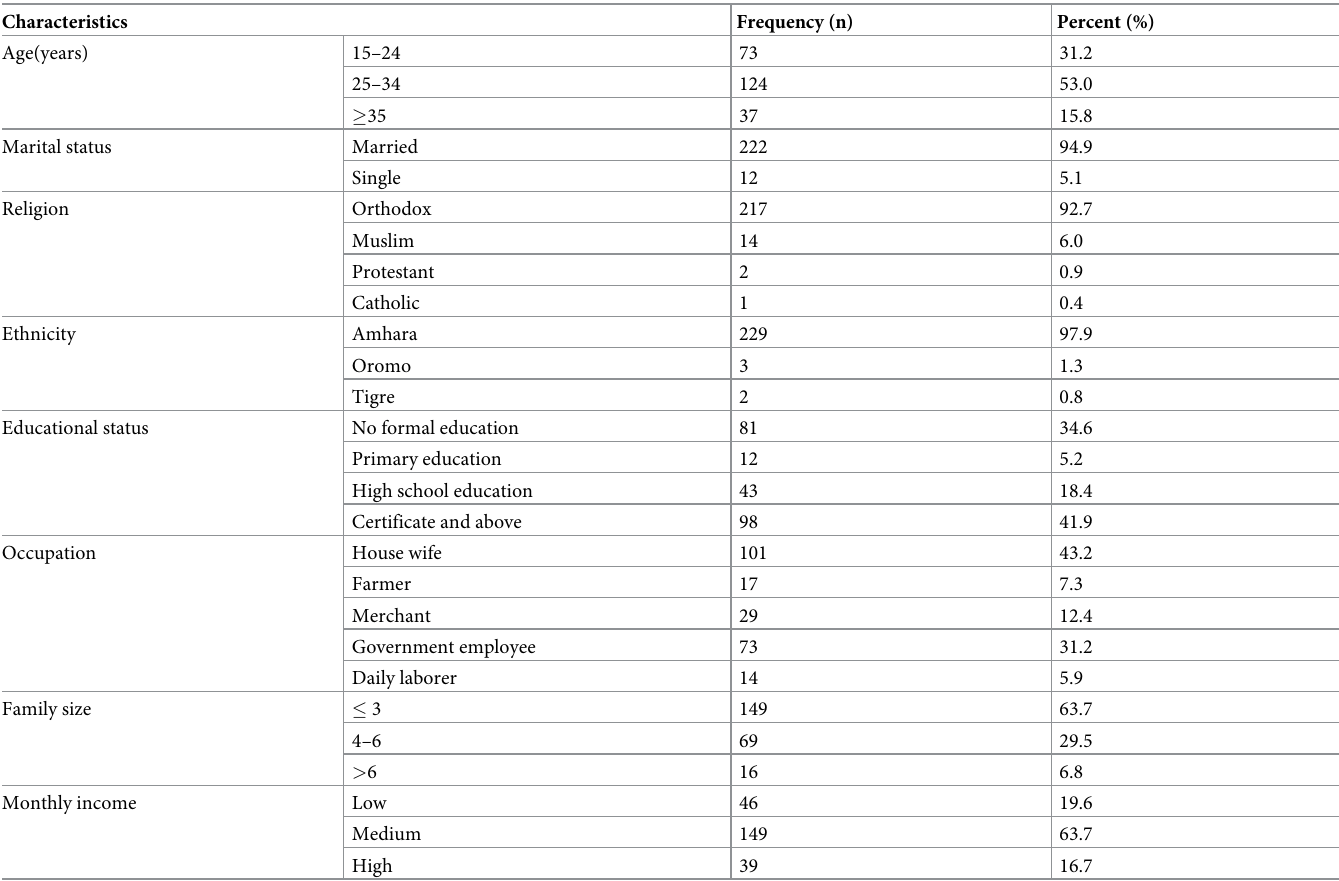
Table 1. Socio-demographic characteristics of the study participants, Northwest Ethiopia, 2016. (n = 234). Characteristics